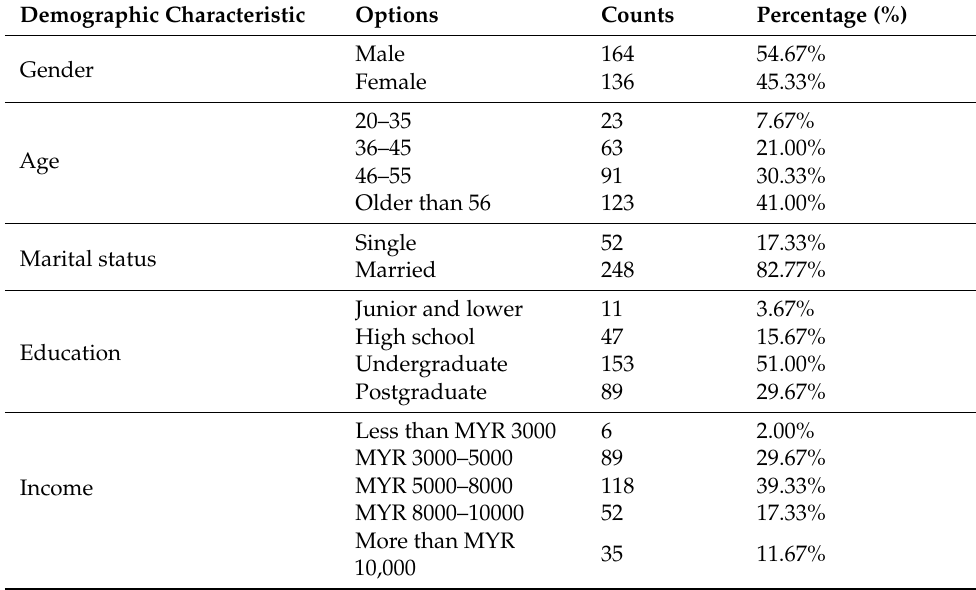
Table 1. Demographic